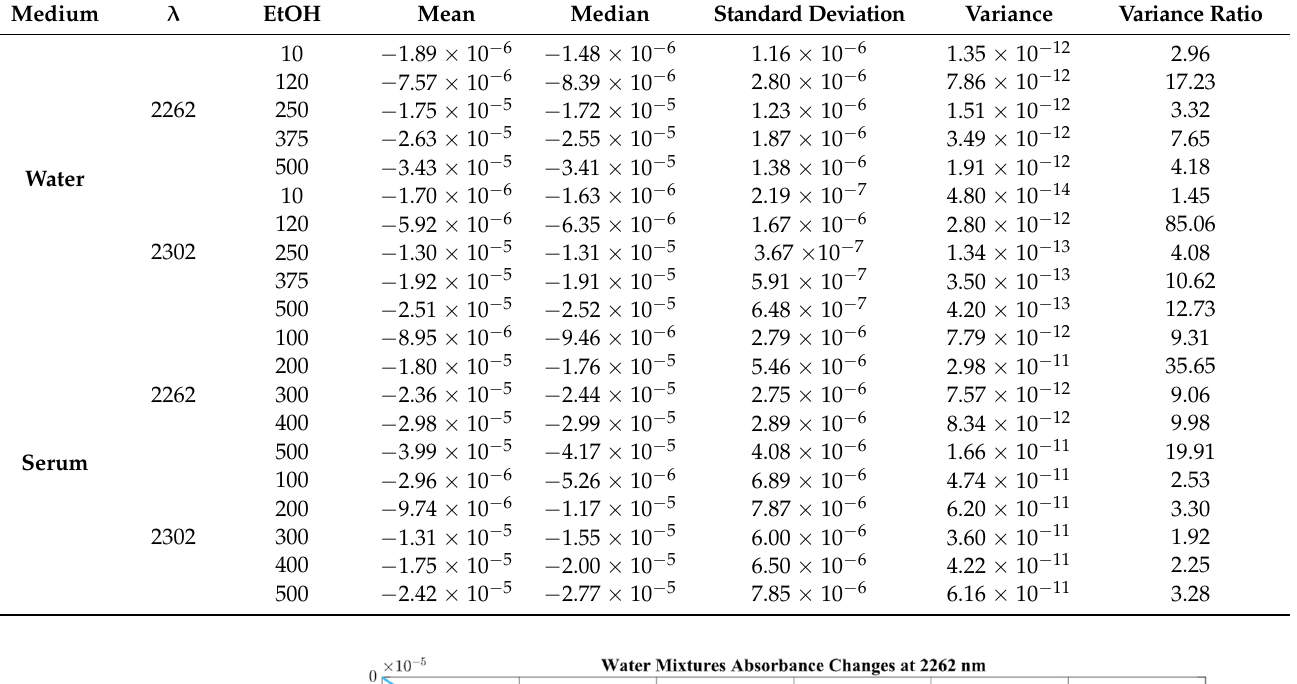
Table 1. Statistical analysis of the absorbance variance.